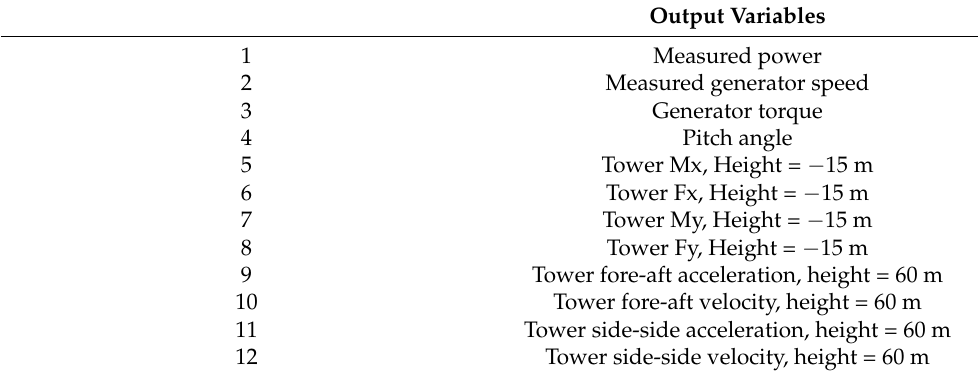
Table A3. Output